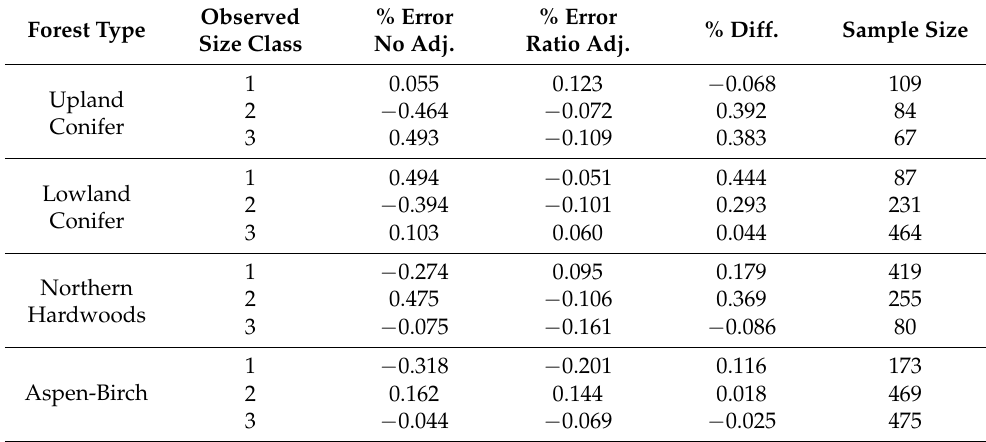
Table 5. Validation statistics (percent error and percent difference) and sample sizes for the age class to size class crosswalk by forest type across all FIA plot records spanning 2014–2018. Sample sizes are those for observed size classes, which are coded as 1—sawtimber, 2—poletimber, and 3— seedling/sapling. Percent errors are given for using the crosswalk alone and with the ratio ad- justments. Percent differences quantify the relative change in percent accuracy from including the adjustments, with positive values indicating an